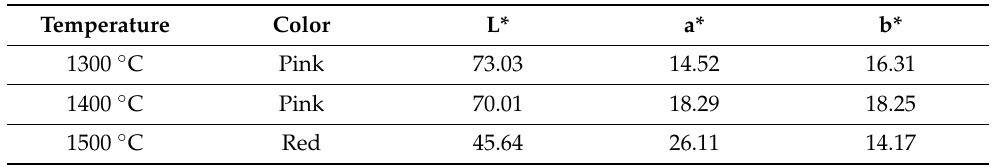
Table 4. Chromatic coordinates values of glazed tiles in the Y 0.98 Al 0.98 Cr 0.04 O 3 system at different firing temperatures.